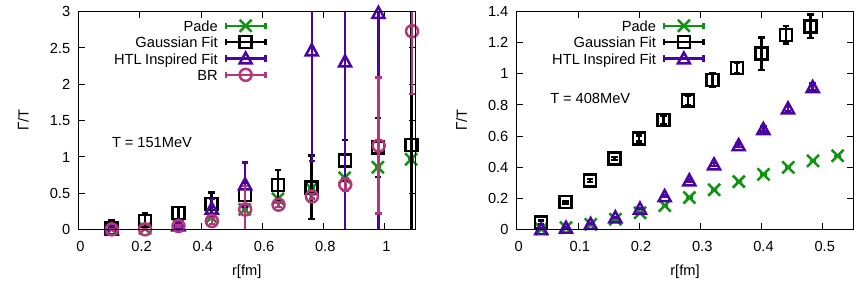
Figure 2. Extracted values of Γ divided by the temperature at T = 151MeV (left) and at T = 408MeV (right) according to the four complementary methods used in